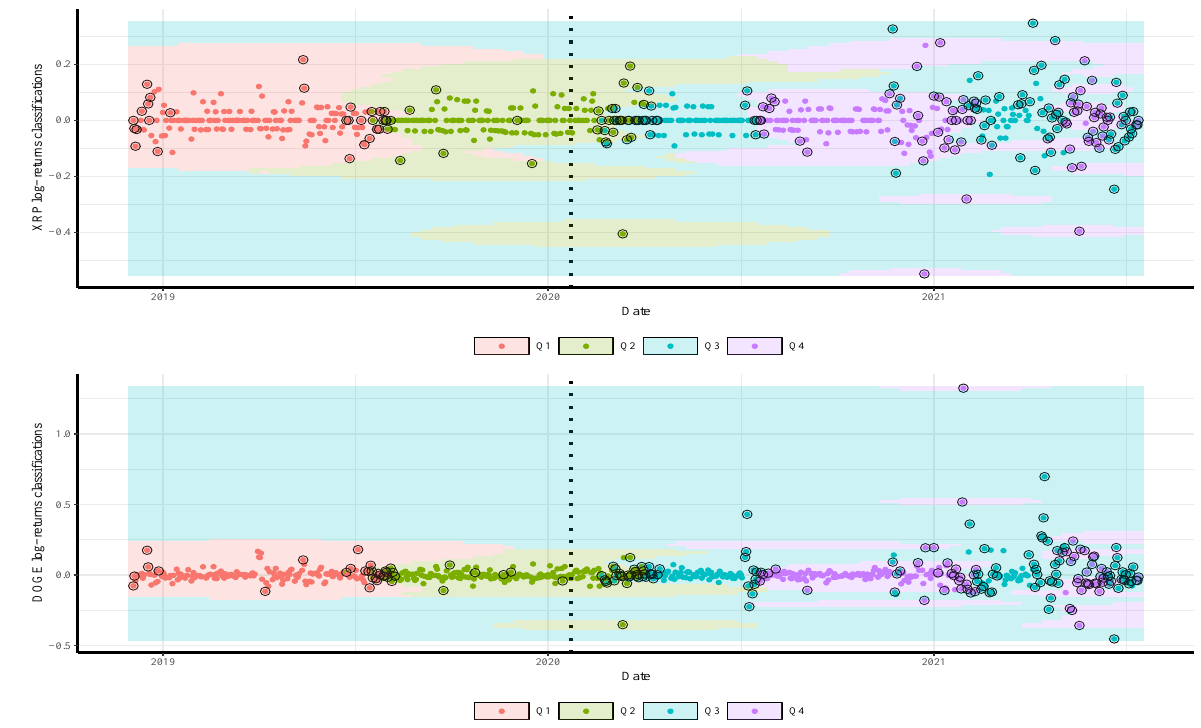
Figure 7. Classifications of XRP ( top ) and DOGE ( bottom ) daily returns based on quartiles of daily gold prices predicted by SVM model. The vertical dotted line represents the threshold between the pre-COVID-19 period ( left ) and ongoing COVID-19 period ( right ) to visualize its impact on the cryptocurrency